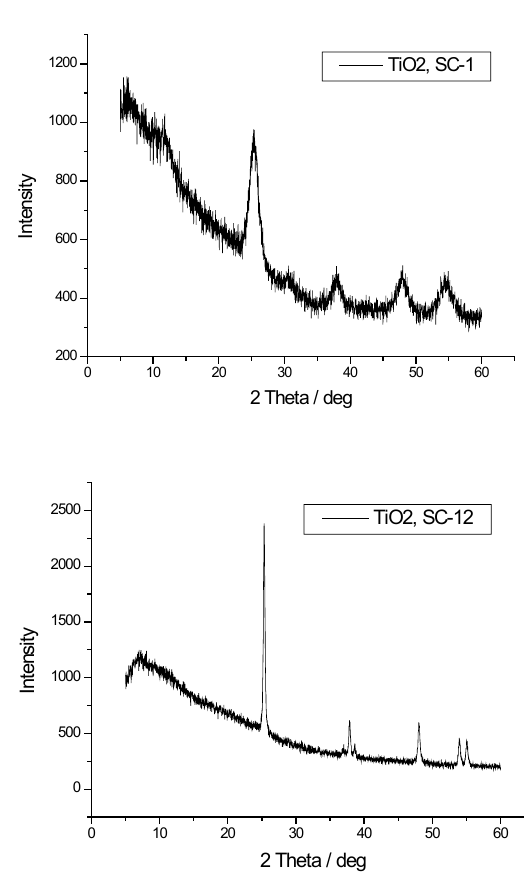
Figure 5. XRD patterns of sol-gel TiO (anatase) after hydrothermal 2 treatment for 1 h at 100°C (top) and after calcinations at 400°C